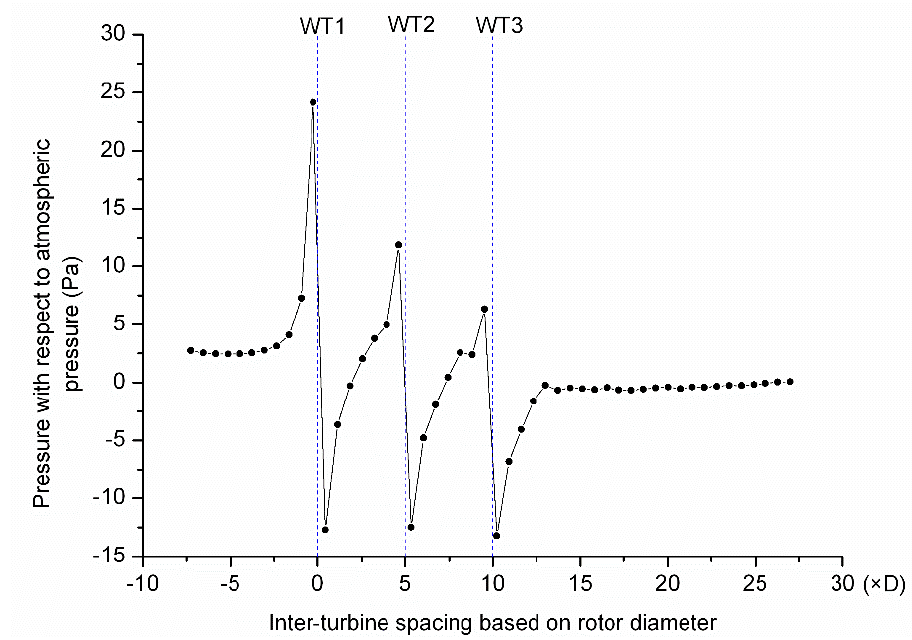
Figure 9. Gage pressure distribution along the center line in streamwise direction at the reference height for case 3 (L2 =